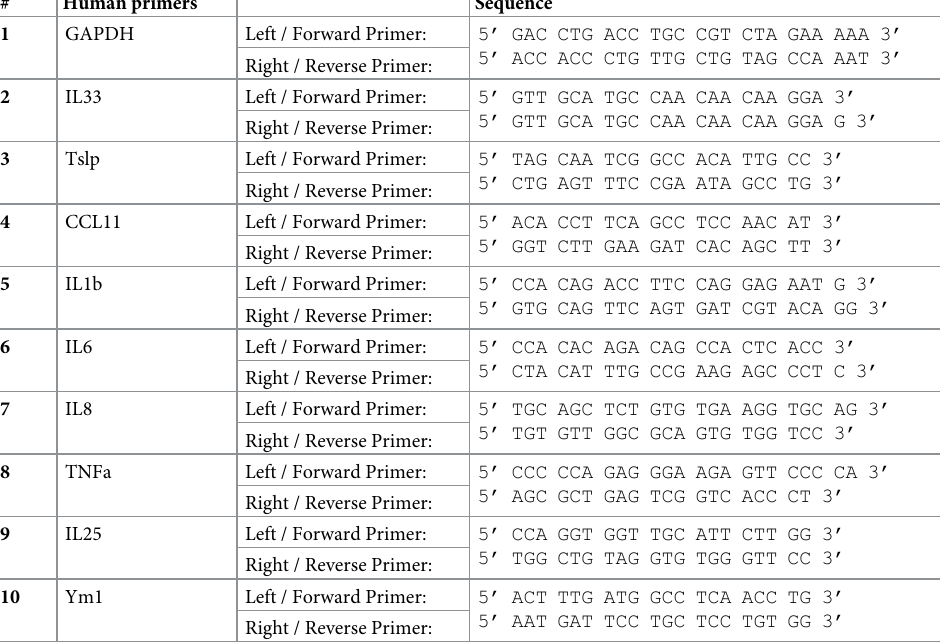
Table 2. Human primers.